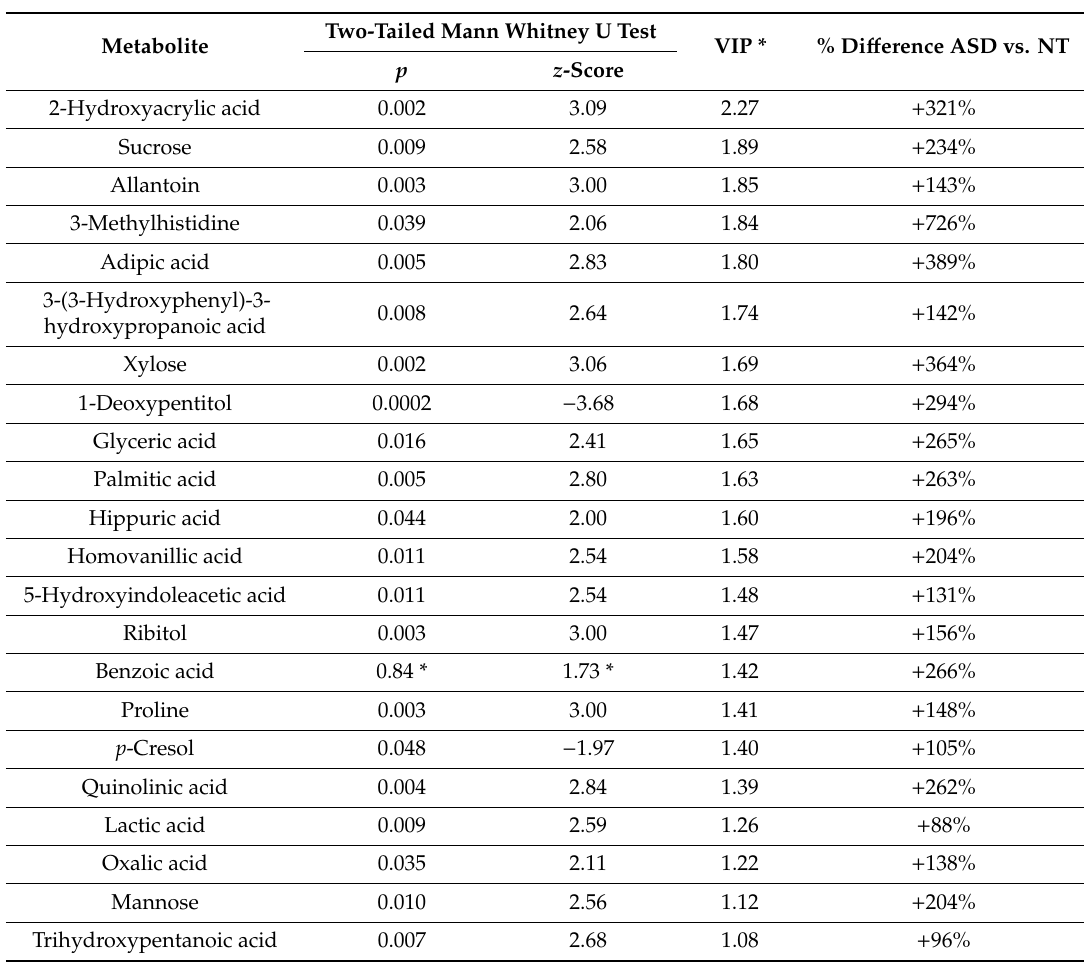
Table 4. List of the most significant metabolites, obtained by univariate and multivariate statistical analysis, discriminating ASD children with severe autism spectrum disorder core symptoms (ADOS-2 CSS ≥ 8) from those with mild-to-moderate core symptoms (ADOS-2 CSS < 8).